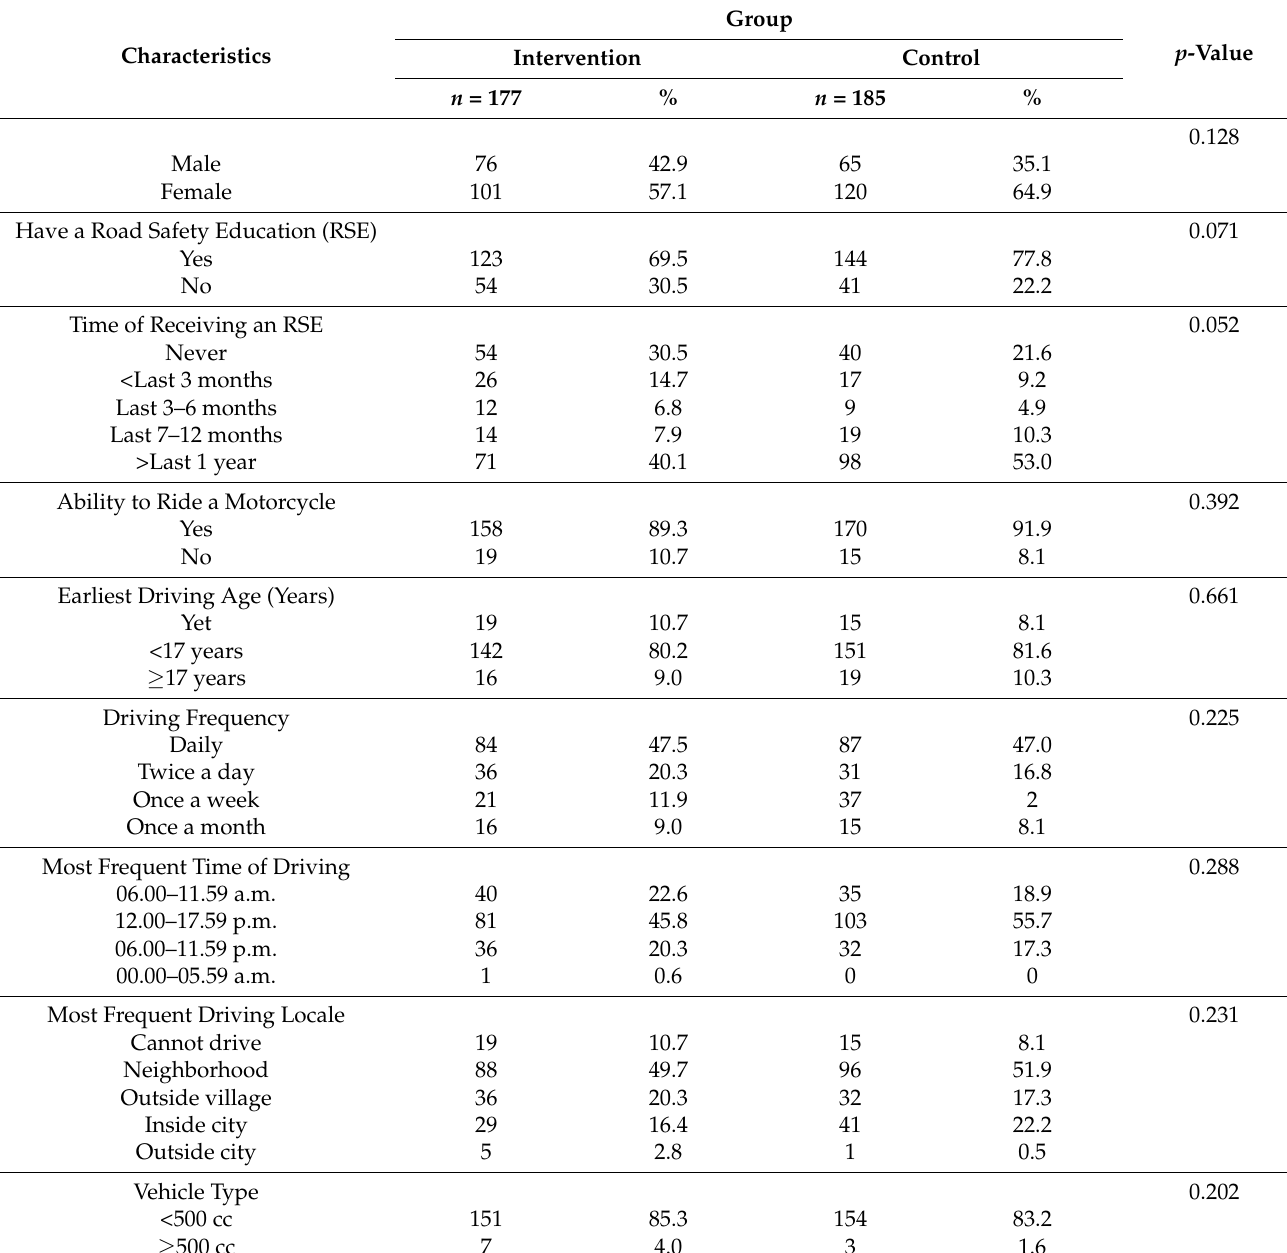
Table 1. Characteristics of research